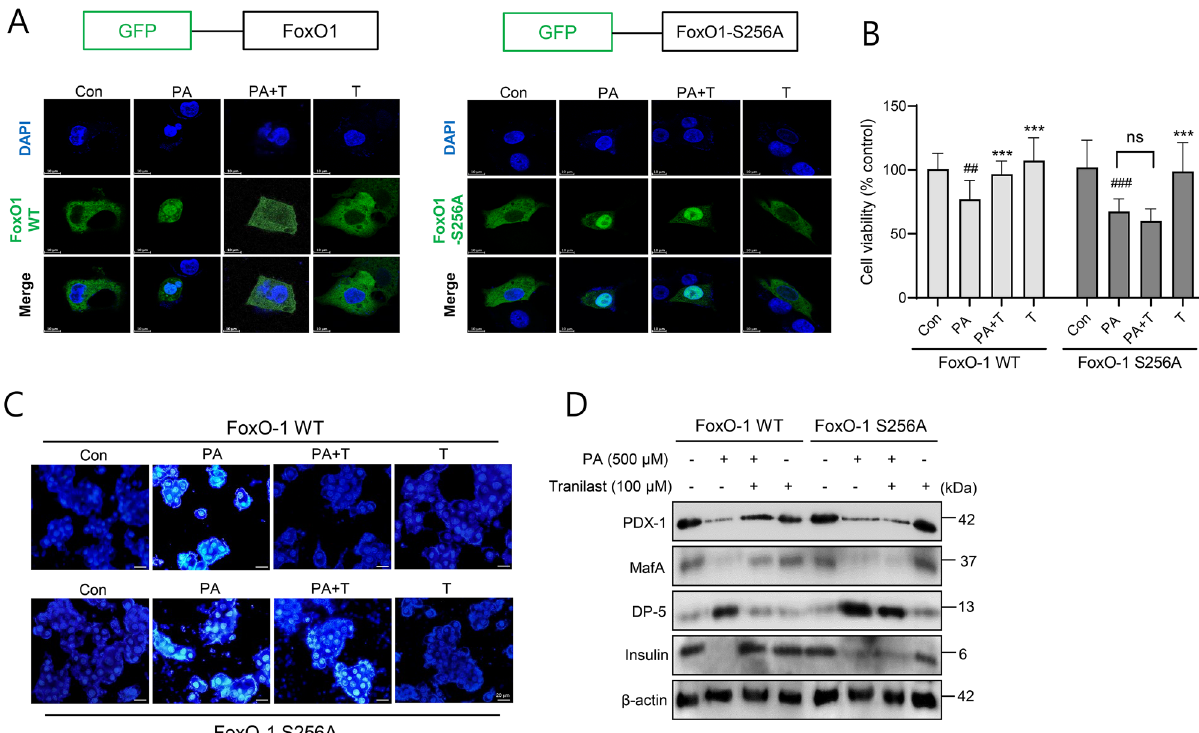
Figure 6. Effects of FoxO-1 S256A mutant on tranilast action. ( A ) Either FoxO-1 wild type (WT) or FoxO-1 mutant (S256A) was transfected into CHO cells, and the FoxO-1 localization after tranilast (100 μM) and PA (500 μM) treatment was observed using confocal microscopy. (B–D) INS-1 cells were transfected with either FoxO-1 WT or FoxO-1 mutant, and then treated with tranilast (100 μM) in the presence of PA for 24 h. Cell viability (B) , DAPI staining (C) and western blot (D) were determined (scale bar = 20 μm). Original scans of whole blots are shown in Supplementary information. Data are expressed as mean ± SD of three independent experiments, each done in duplicate (B) . Representative results are shown (A,C,D) . ## p < 0.01, ### p < 0.005 versus control, *** p < 0.005 versus PA